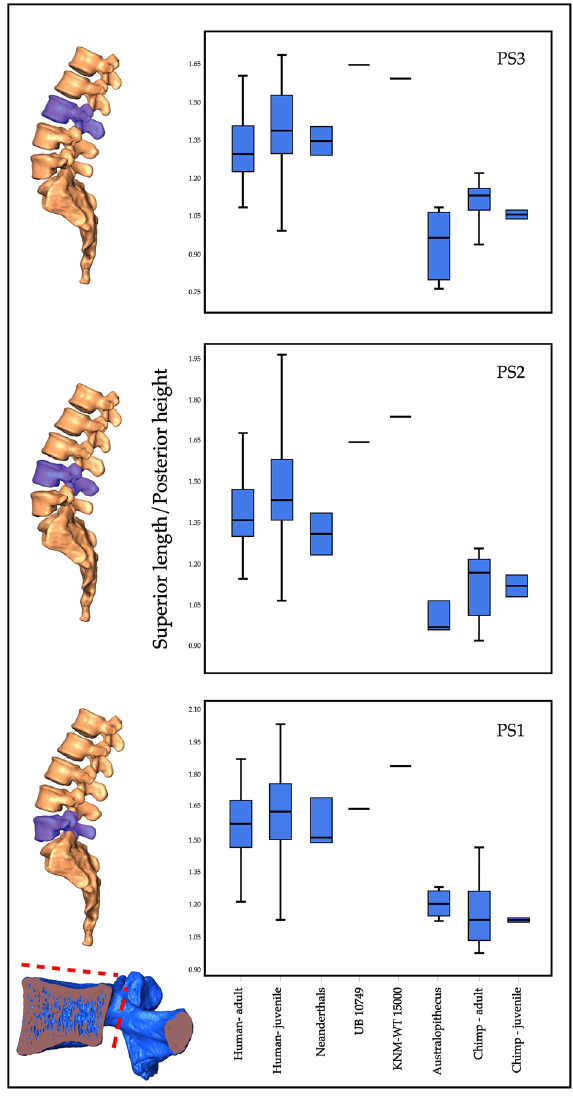
Figure 4. Comparison of UB 10749 to other hominoids. Vertebral body ratio (superior length to posterior height) of each of the lower 3 presacral vertebra in modern humans, neandertals, australopith, chimpanzees, KNM-WT 15000 and UB 10749. Note that UB 10749 is consistently falls within the range of Homo , and beyond the range of chimpanzees and